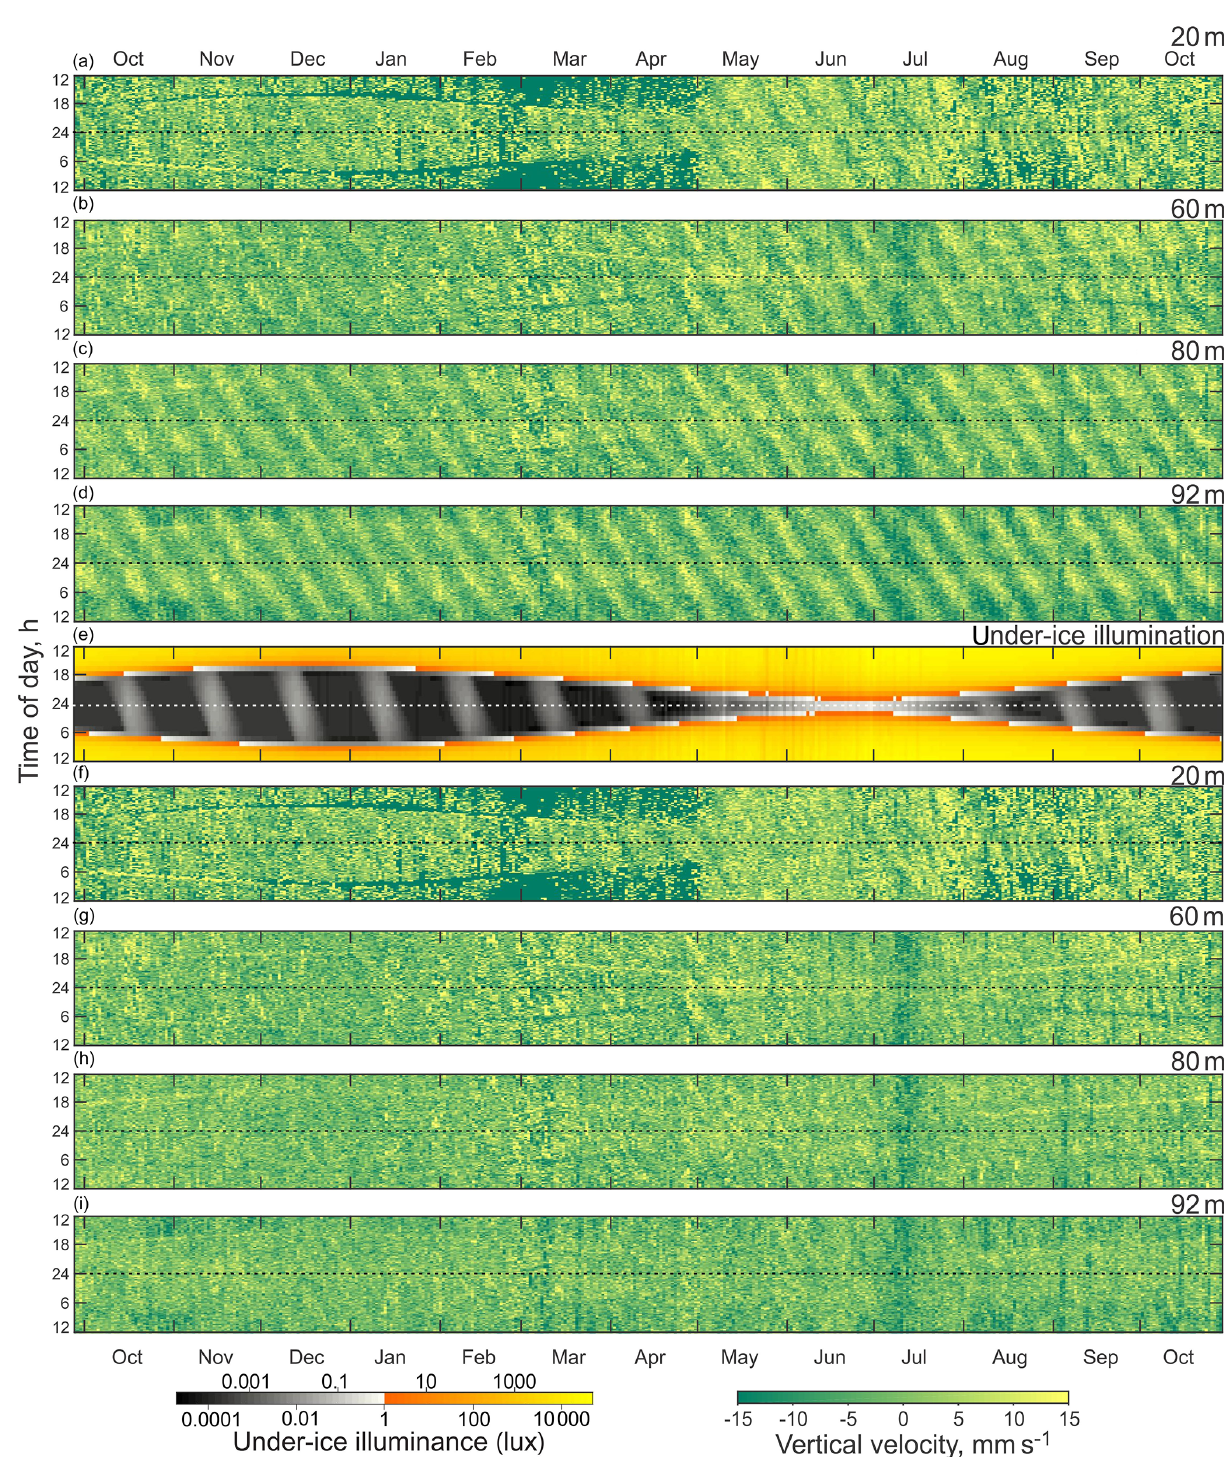
Figure 4. Actograms of (a–d) ADCP-measured vertical velocity (mms − 1 ) at four depth levels: (a) 20m, (b) 60m, (c) 80m, and (d) 92m. (e) Modeled under-ice illuminance and (f–i) residual vertical velocity (mms − 1 , tidal signal subtracted) at four depth levels: (f) 20m, (g) 60m, (h) 80m, and (i) 92m. Positive and negative values correspond to the upward and downward net flux. Dashed horizontal lines represent astronomical